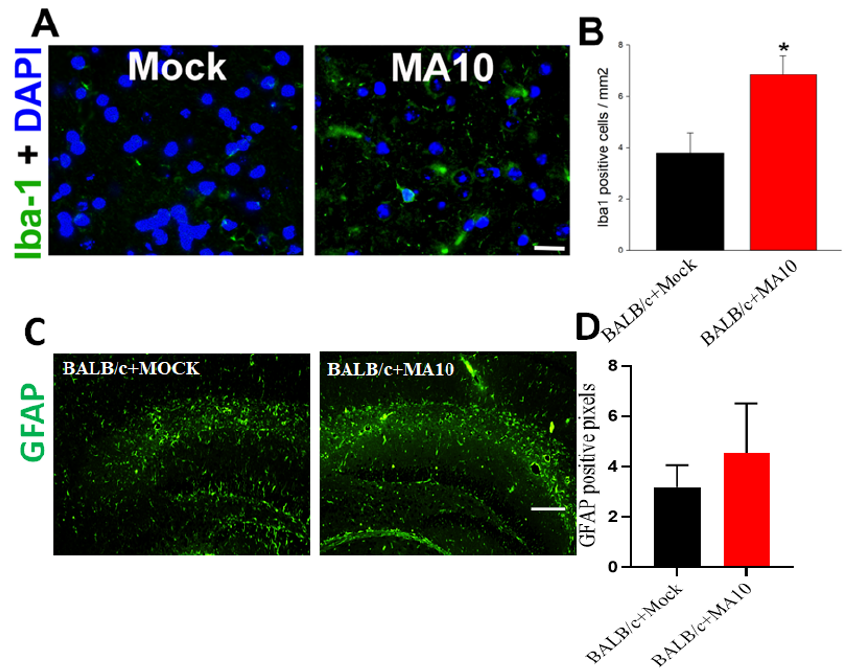
Figure 4. SARS ‐ CoV ‐ 2 (MA10) infection significantly increases Iba ‐ 1 positive microglial cells in the cortex region of the brain in 1 ‐ year ‐ old female BALB/c mice. 1 ‐ year ‐ old female BALB/c mice